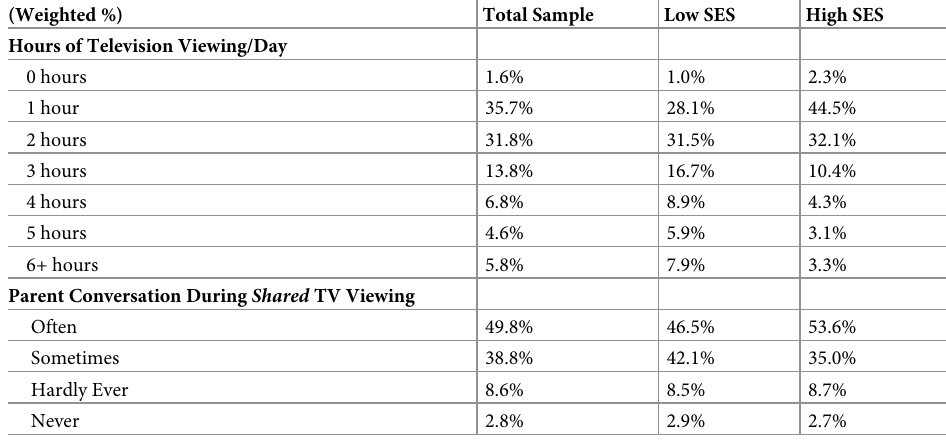
Table 2. Descriptive characteristics of amount of television viewing and parent conversation during shared televi- sion